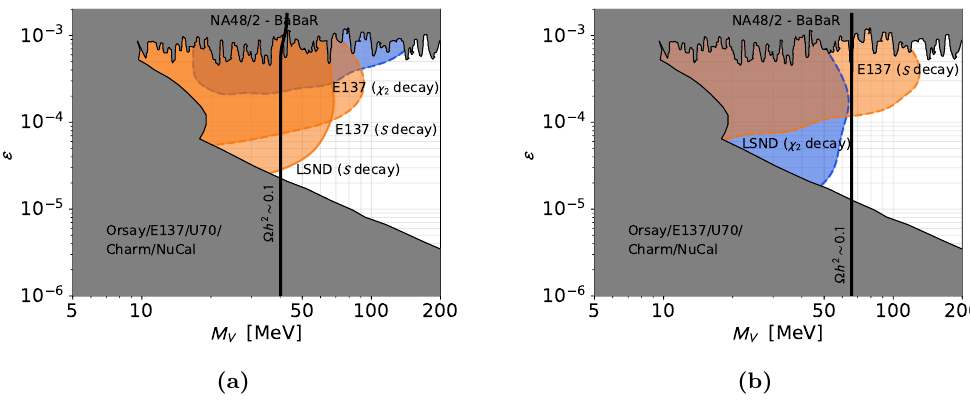
Figure 9. Bounds on the forbidden regime from the E137 [30], LSND [77] arising from dark Higgs boson decay (orange shaded regions), from visible dark photon searches (dark grey regions from [5]), and from (cid:31) 2 decay (blue shaded region). The thick black lines correspond to points featuring the correct relic density of DM. We varied M V and " using (cid:11) D = 0 : 8 and (a) M S : M (cid:31) : M V : (cid:1) (cid:31) = 5 : 1 : 4 : 0 : 3 and (b) M S : M (cid:31) : M V : (cid:1) (cid:31) = 6 3 3